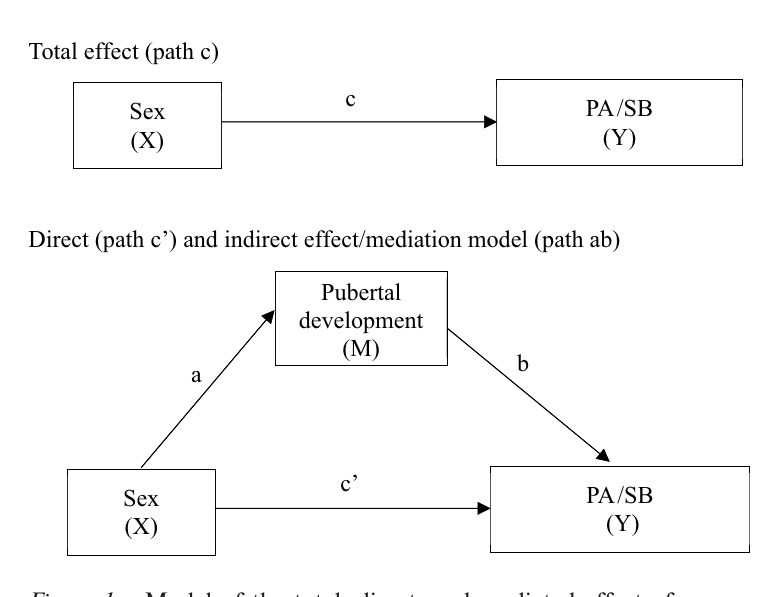
Figure 1. Model of the total, direct, and mediated effect of sex on physical activity (PA) or sedentary behavior (SB) . Complete media- tion occurs when variable X no longer affects Y after M has been introduced (path c’ = 0). Partial mediation occurs when the path from X to Y is reduced in absolute size but remains different from zero after the potential mediator is